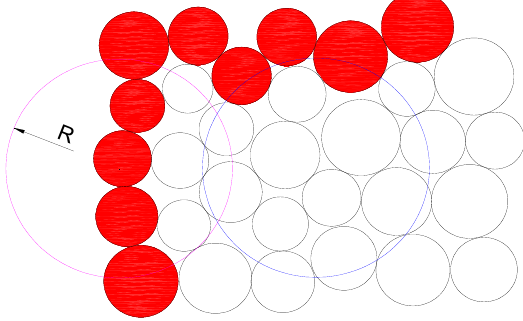
Figure 5. Boundary